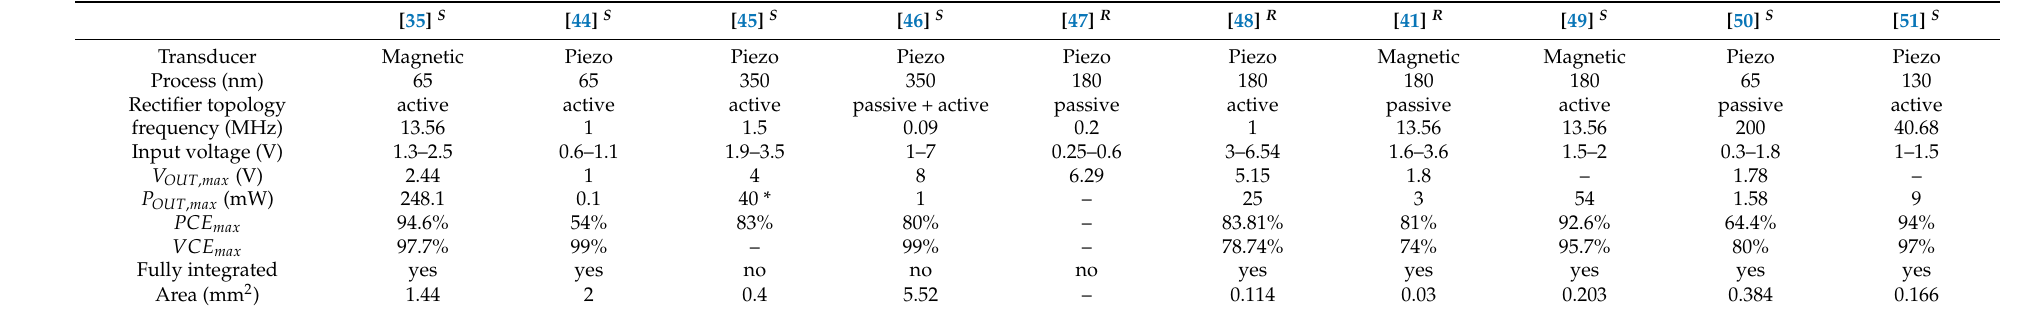
Table 1. Comparison of different